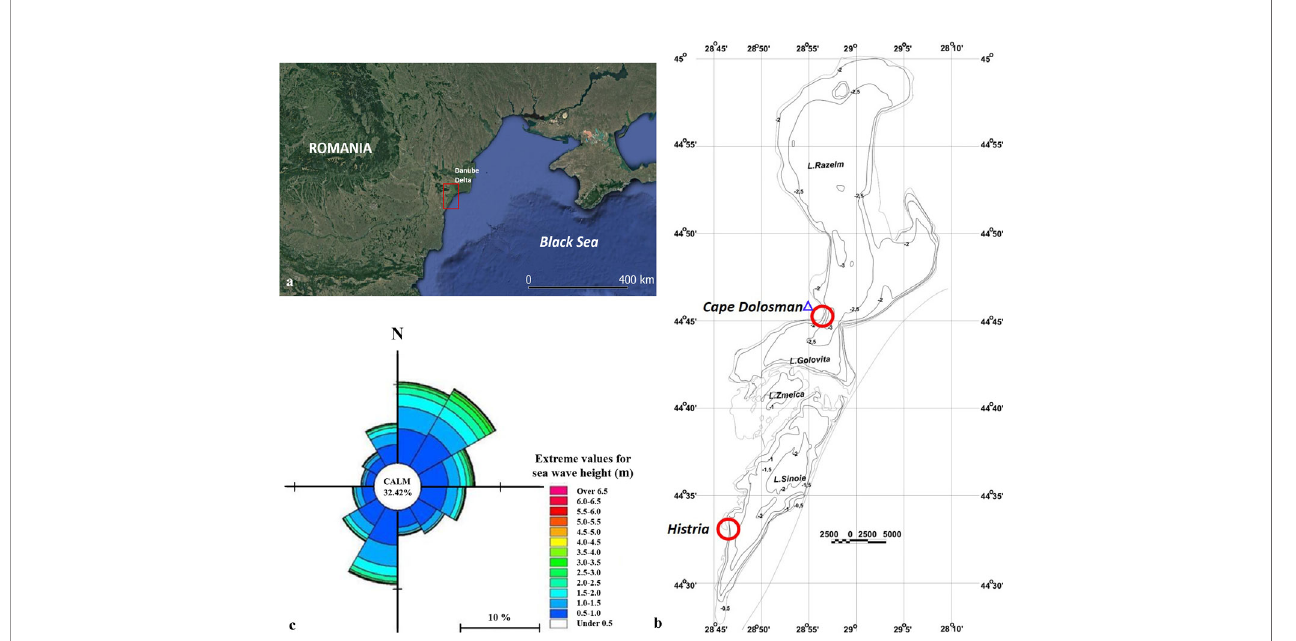
FIGURE 2 | (A) Location of the Razem-Sinoe Lagoon System, in the Danube Delta, Romania; (B) Site 1 (Cape Dolosman) and Site 2 (Histria),shown as red circles in the north and south of the lagoon system, respectively and Jurilovca meteorological station (blue triangle). Detailed bathymetric map of the lagoon system, redrawn from Dimitriu et al., 2008. (C) . Wind rose offshore Danube Delta Black Sea Shore (July 1992 – December 2010) (Halcrow,